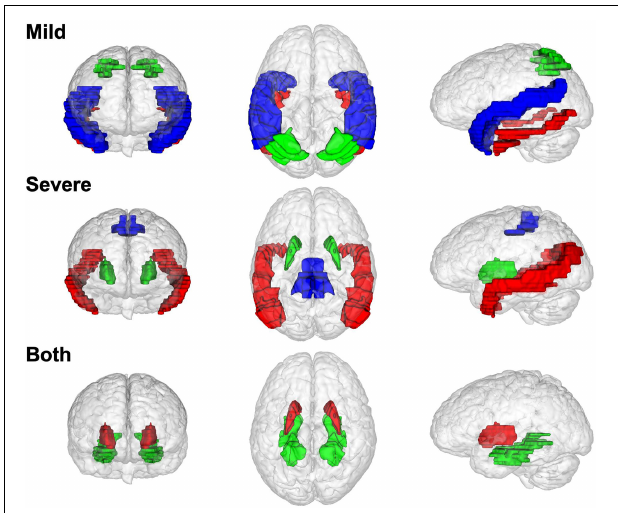
FIGURE 4 | The brain region distribution of non-preserved modules in different Alzheimer’s disease stages. Modules that non-preserved in mild stages are located in superior temporal gyrus (blue), inferior temporal gyrus (red), and superior parietal lobule (red). Modules that non-preserved in severe stage are located in middle temporal gyrus (red), putamen (green), precentral gyrus (blue). Modules that non-preserved in both two disease stages are located in putamen (red) and parahippocampal gyrus (green). FIGURE 5 | Cell type enrichment of non-preserved modules in different brain